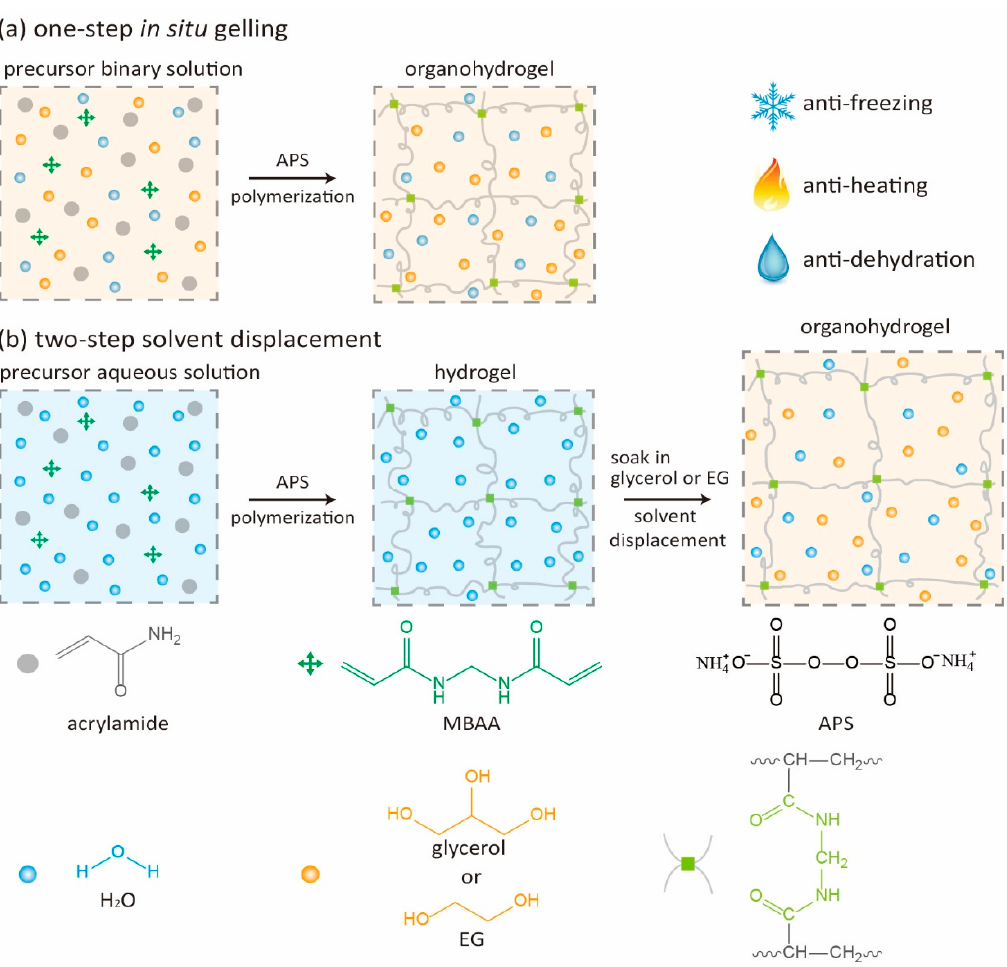
Figure 1. The schematic illustration for synthesizing the polyacrylamide (PAAm) organohydrogels with ( a ) one-step in-situ gelling strategy and ( b ) two-step solvent displacement strategy.